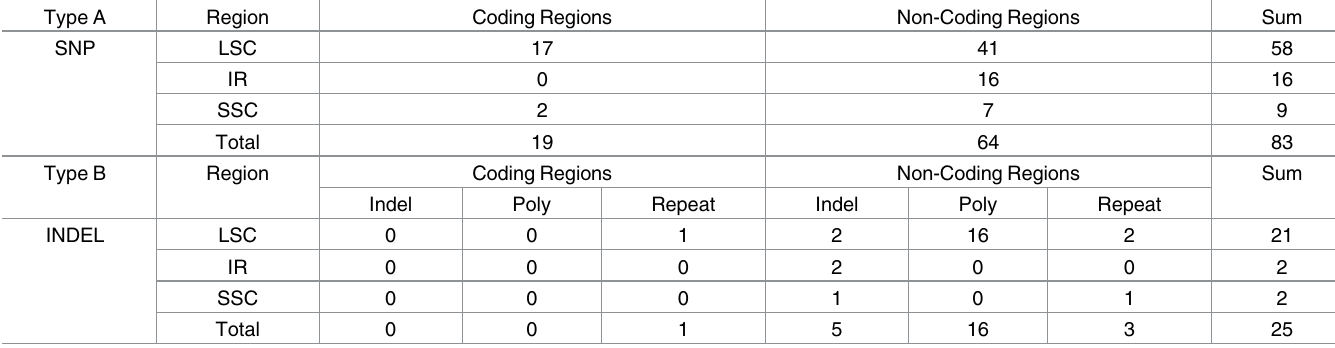
Table 4. The number and distribution of polymorphisms of chloroplast genome between two Chikusichloa species. Type A